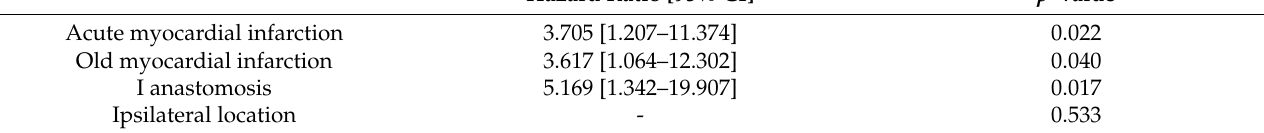
Figure 4. Freedom from the composite outcome of recurrent angina and coronary re-intervention (inverse probability weighting-adjusted comparison).